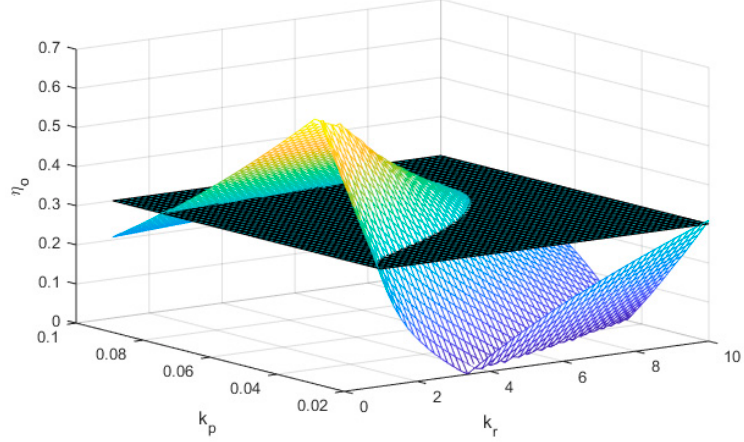
Figure 9. Minimum distance to the critical point by the Nyquist trajectory of Go with PMR control; color indicates the values of η 0 .